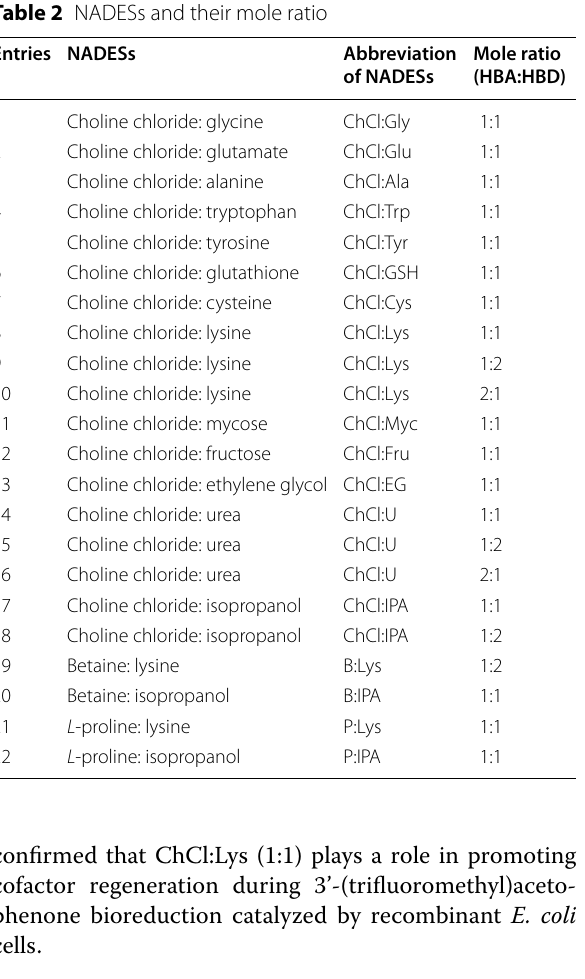
Table 2 NADESs and their mole ratio